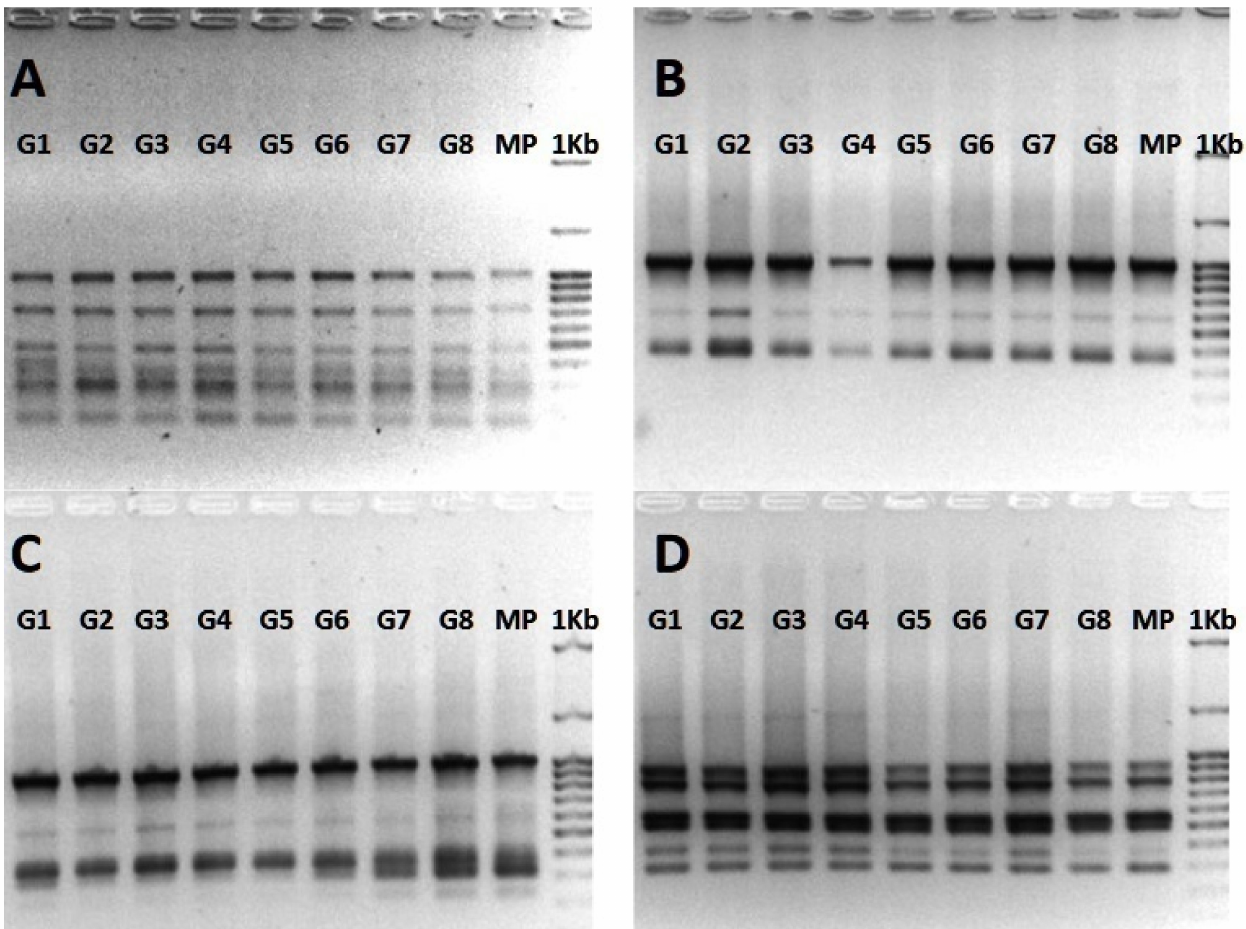
Figure 5. ISSR amplification profiles of eight plantlets (G1–G8), derived from cold-stored germinated artificial seeds, and mother plant (MP) of G. jasminoides obtained with primers UBC 841 ( A ), UBC 811 ( B ), UBC 810 ( C ) and UBC 816 ( D ). The size of the amplified bands was calculated using 1kb DNA ladder (100–3000 bp) and the image has been converted to black and white and to